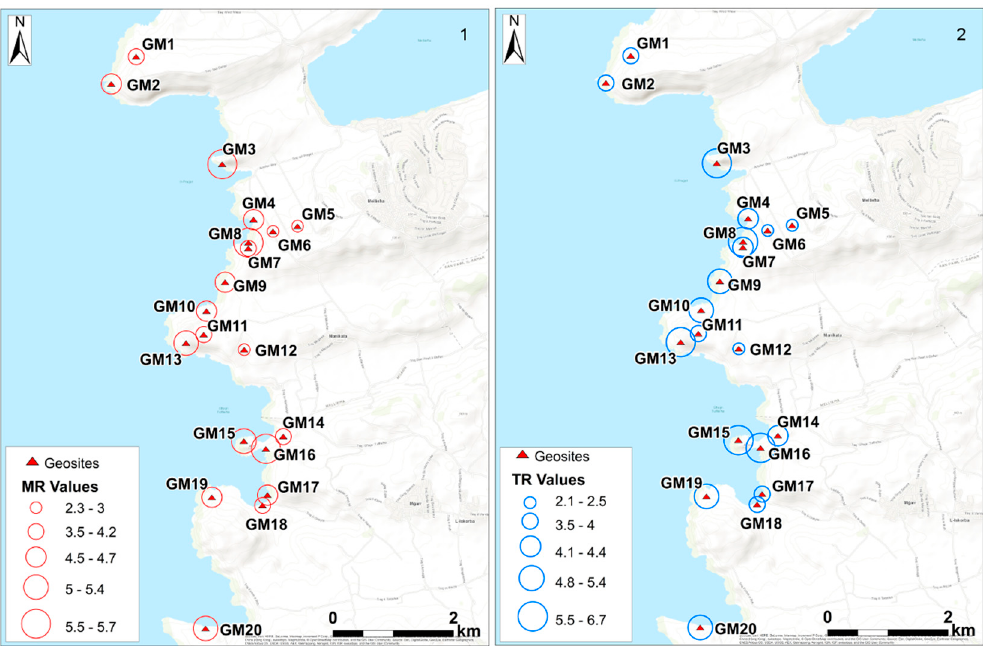
Figure 7. Geosite distribution according to management ranking ( 1 ) and tourism ranking ( 2 ) in Malta study area (GEOMAL).